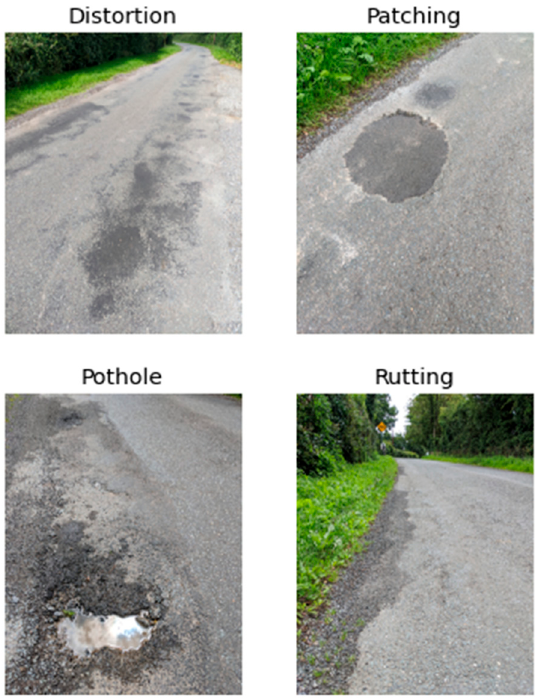
Figure 6. Examples of defects observed from the designated road